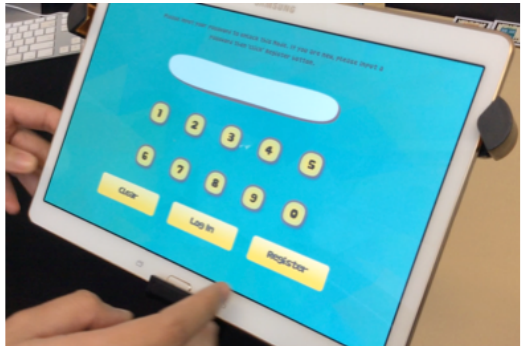
Figure 3. Registration page of Parent Mode